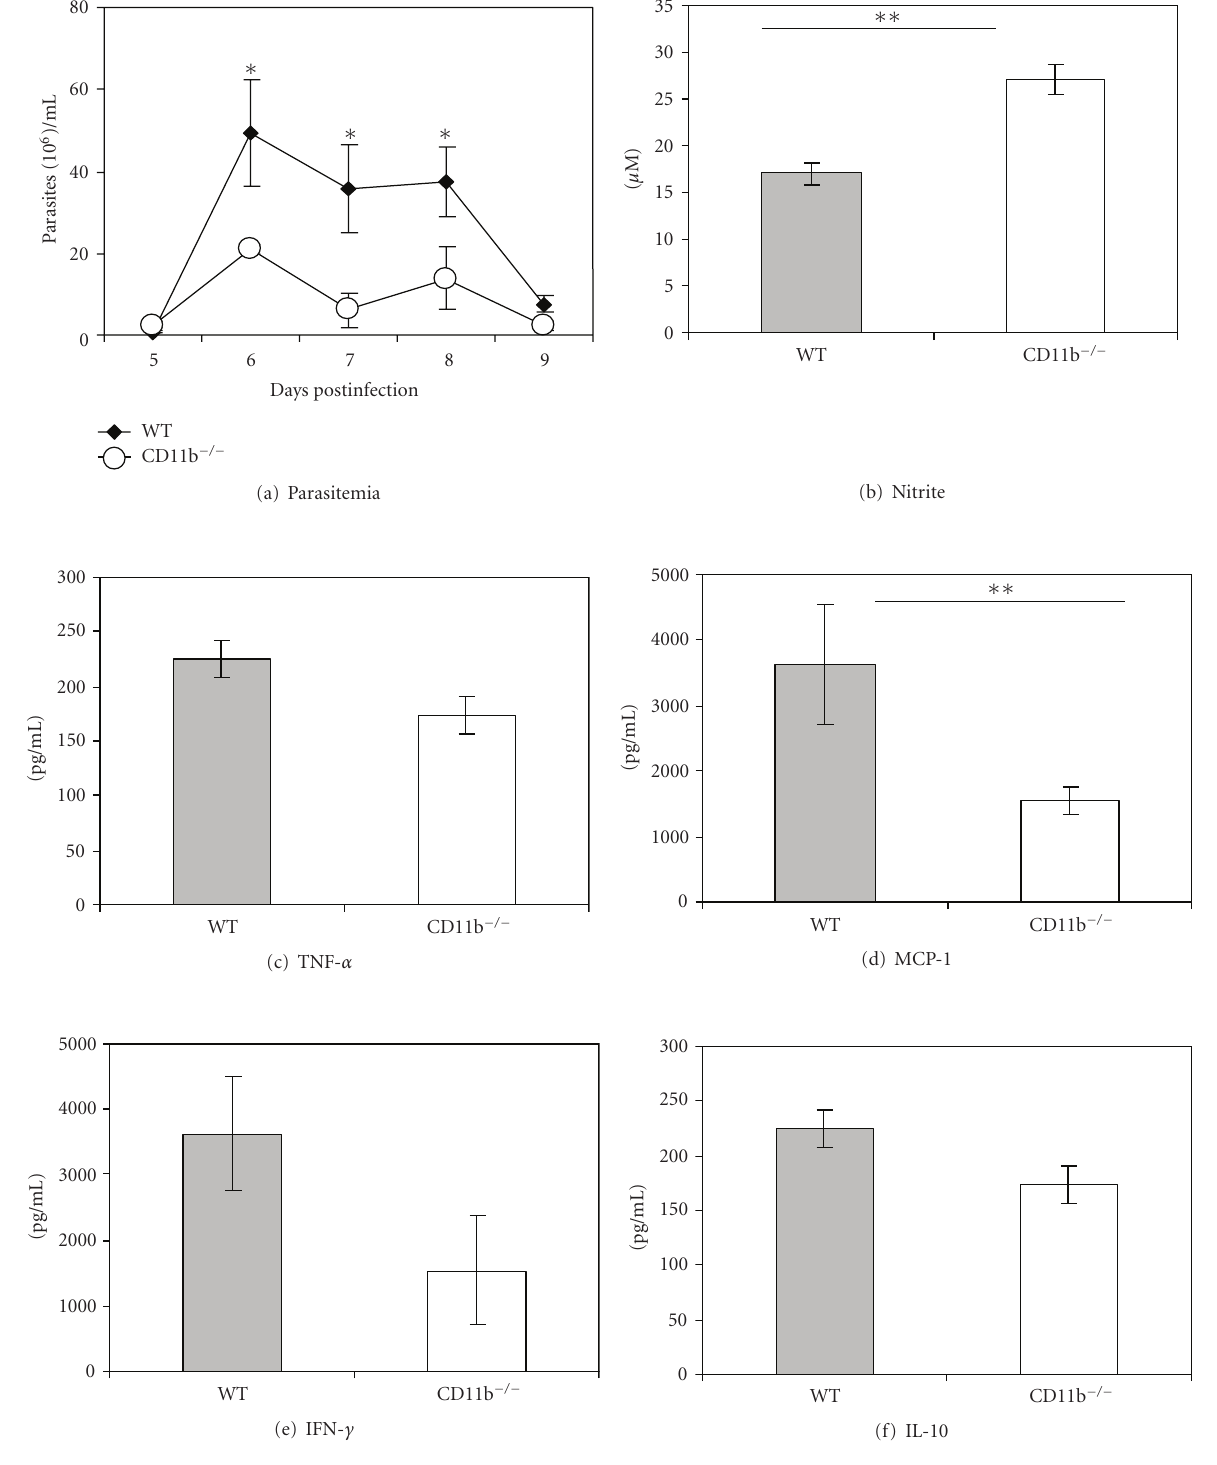
Figure 6: CD11b − / − mice infected with T. congolense have a higher production of nitric oxide and show better control of the initial parasitemia than infected wild-type mice. Mice were infected with 10 3 T. congolense TC13. The first parasitemia was shown to be significantly lower in infected CD11b − / − mice than in infected wild-type (WT) mice (a). Spleen cell cultures (day 6) of infected CD11b − / − mice produced significantly more nitrite than spleen cell cultures of infected WT mice (b). Cytokines in the supernatants of spleen cell cultures of CD11b − / − mice and wild-type mice 6 days after infection with T. congolense (c–f). Note: Infected CD11b − / − mice had a significant decrease in production of MCP-1 (d) but no detectable di ff erences in production of TNF- α (c), IL-10 (f), or IFN- γ (e). ∗ P < . 05, ∗∗ P < .